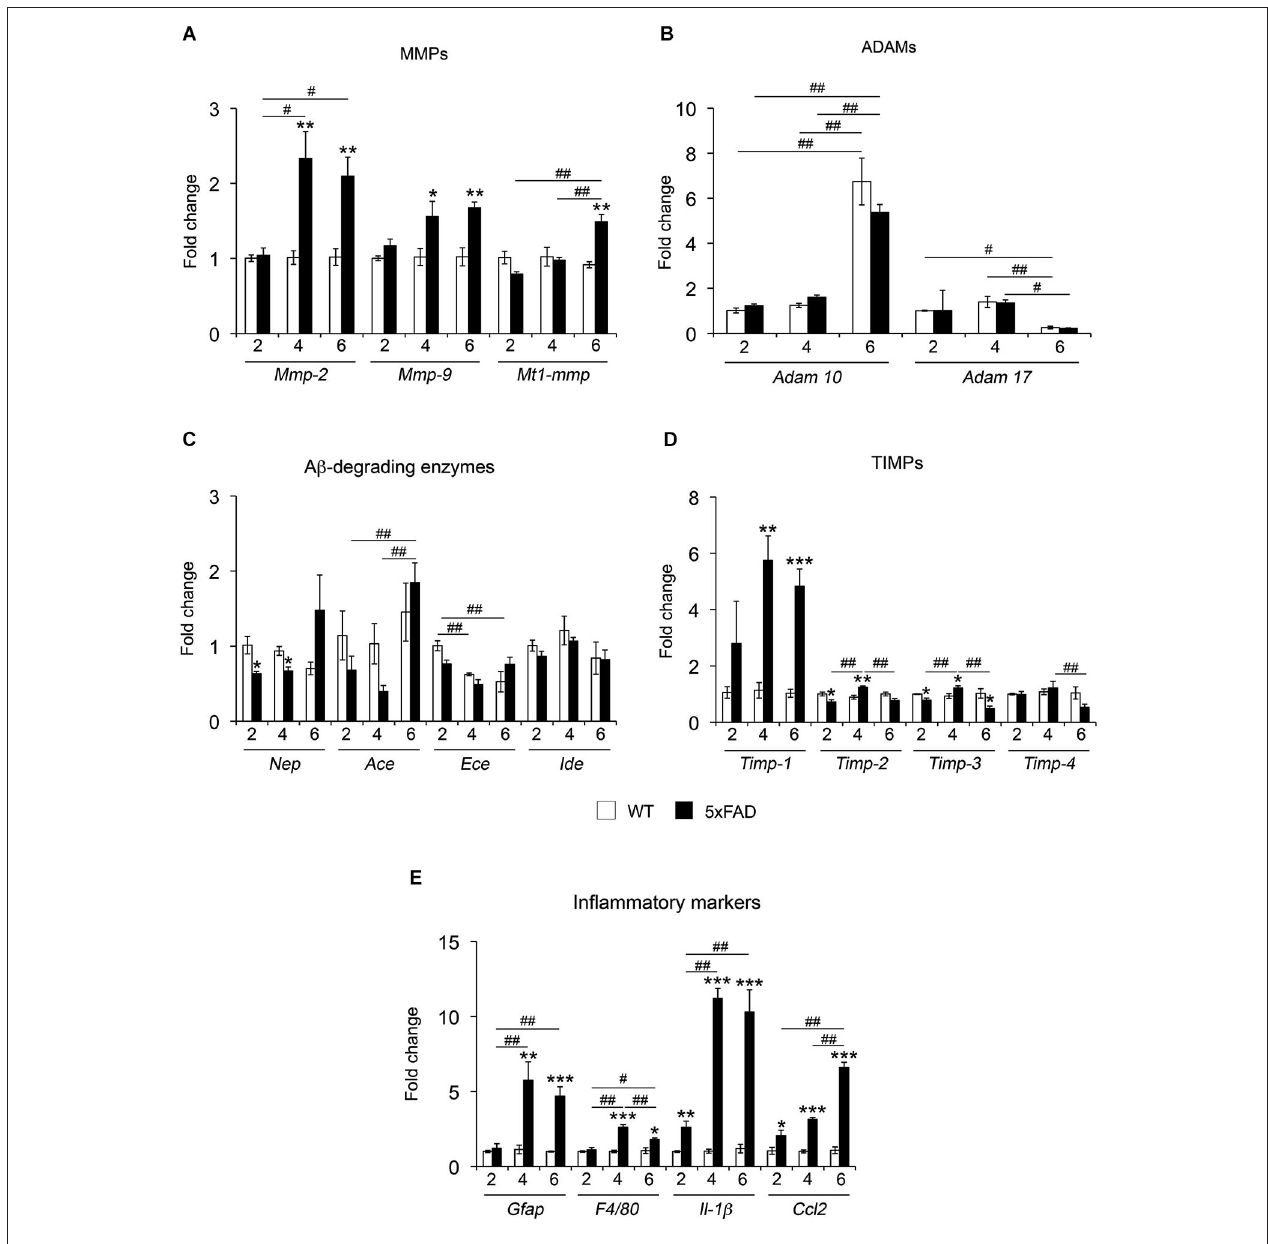
four mice per group representing fold change differences between genotypes. * p < 0.05, ** p < 0.01, *** p < 0.001 when comparing 5xFAD vs . WT of the same age; # p < 0.05, ## p < 0.01, ### p < 0.001 when comparing different ages of the same genotype; ANOVA followed by Tukey’s